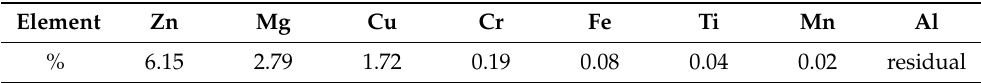
Table 1. AA7075-T6 nominal chemical composition.